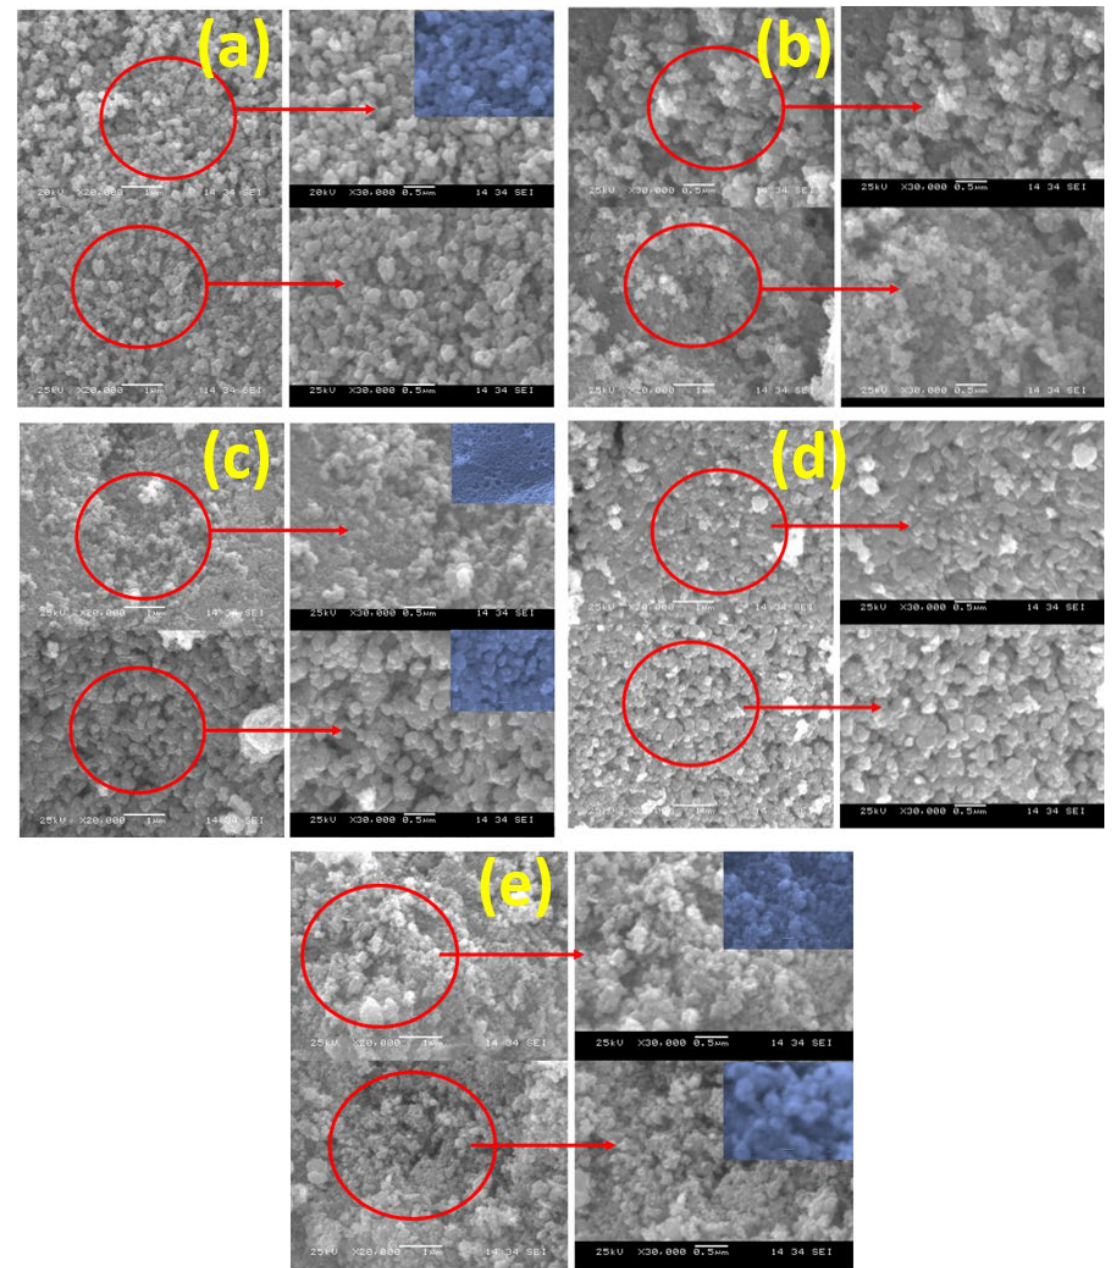
Figure 3. SEM images for ( a ) pure and ( b – e ) Cr-doped ZnO NPs.